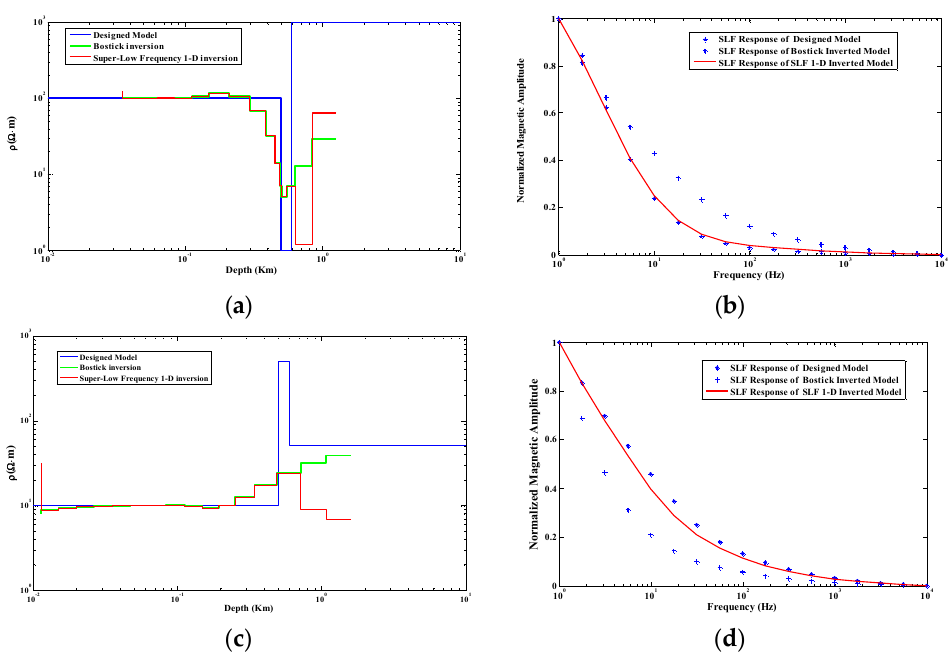
Figure 4. Comparison of the Super-Low Frequency electromagnetic component method (SLF) inversion results and the Bostick inversion. ( a ) Comparison of the inversion results of the low-resistivity target model (100 m thick, with a resistivity of 1 Ω · m); ( b ) the SLF forward response of the low-resistivity target model and the responses of each inverted model; ( c ) Inversion results of the high-resistivity target model (100 m thick, resistivity 500 Ω · m); ( d ) The SLF forward response of the high-resistivity target model and the forward response of the inverted model.